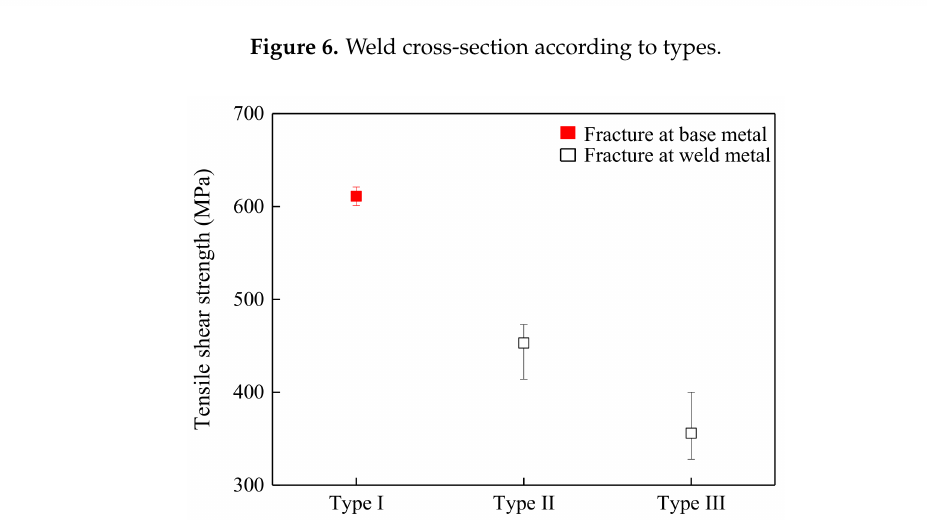
Figure 7. Comparison of the tensile shear strength of welds according to the specimen types.